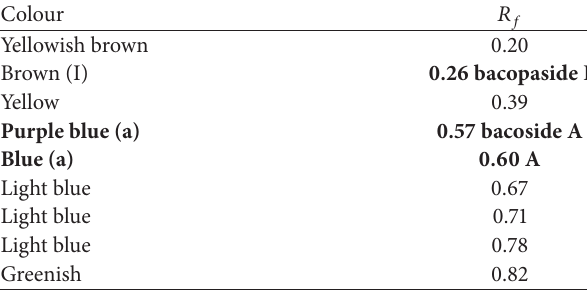
Table 5: 𝑅 𝑓 values and the colour of components present in B. monnieri